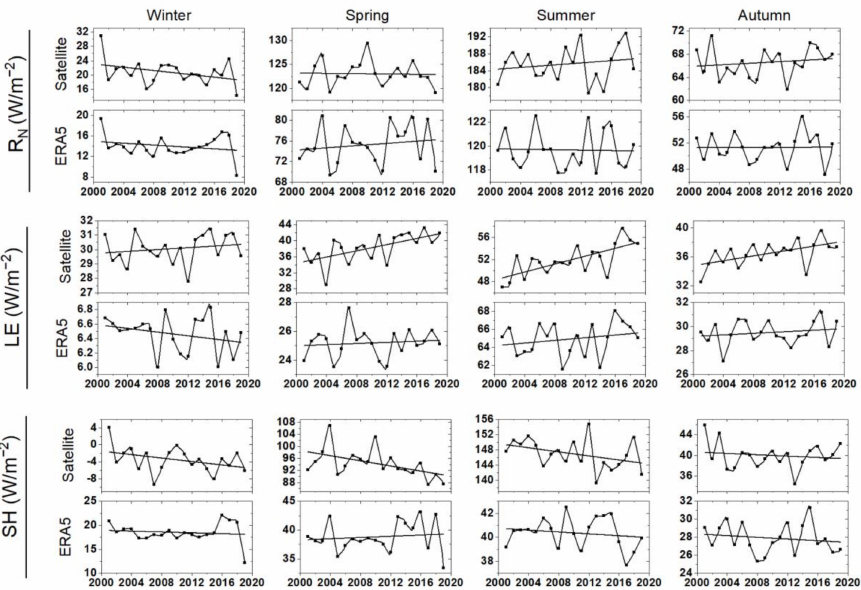
Figure 6. Seasonal analysis of R N , LE, and SH observed from satellite and ERA5 data. Each value rep- resents the aerial average of the particular SEB parameter for the corresponding season. Straight black lines are LR slopes. Table 5. LR slope values of seasonal trends for R N , LE, and SH from satellite and ERA5 data each numerical value represents the corresponding trend line from Figure 6. ** describe 99% significance, while * describes 95% significance. Without * values are insignificant. The values after ± are standard error in LR slope. Data Set Winter Spring